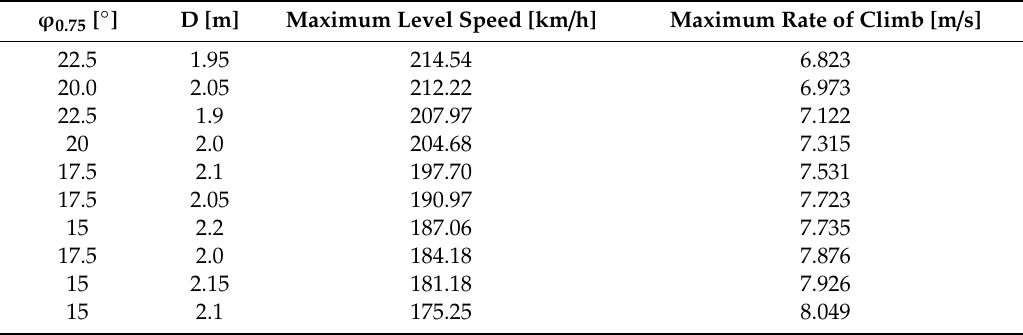
Table 3. Points on the Pareto front for maximum horizontal speed (continuous engine regime) and maximum rate of climb (take-o ff engine regime) (see Figure